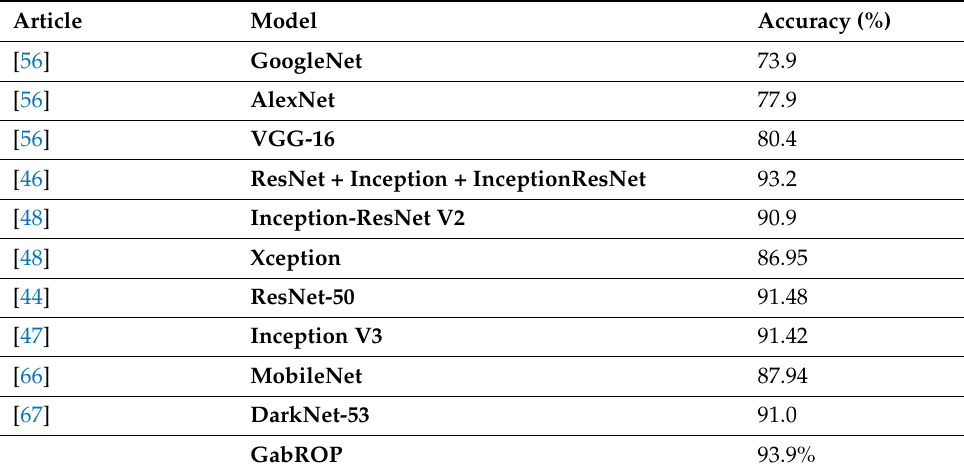
Table 3. An evaluation of GabROP in contrast to recent ROP studies using the same